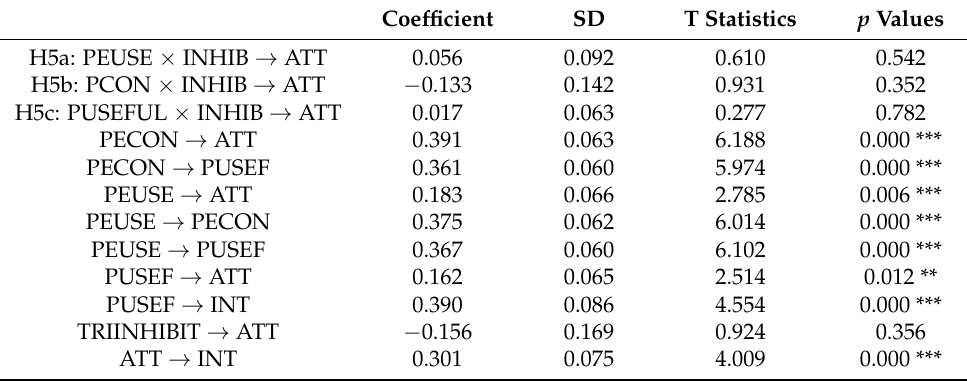
Table 7. Moderating Effect of TRI